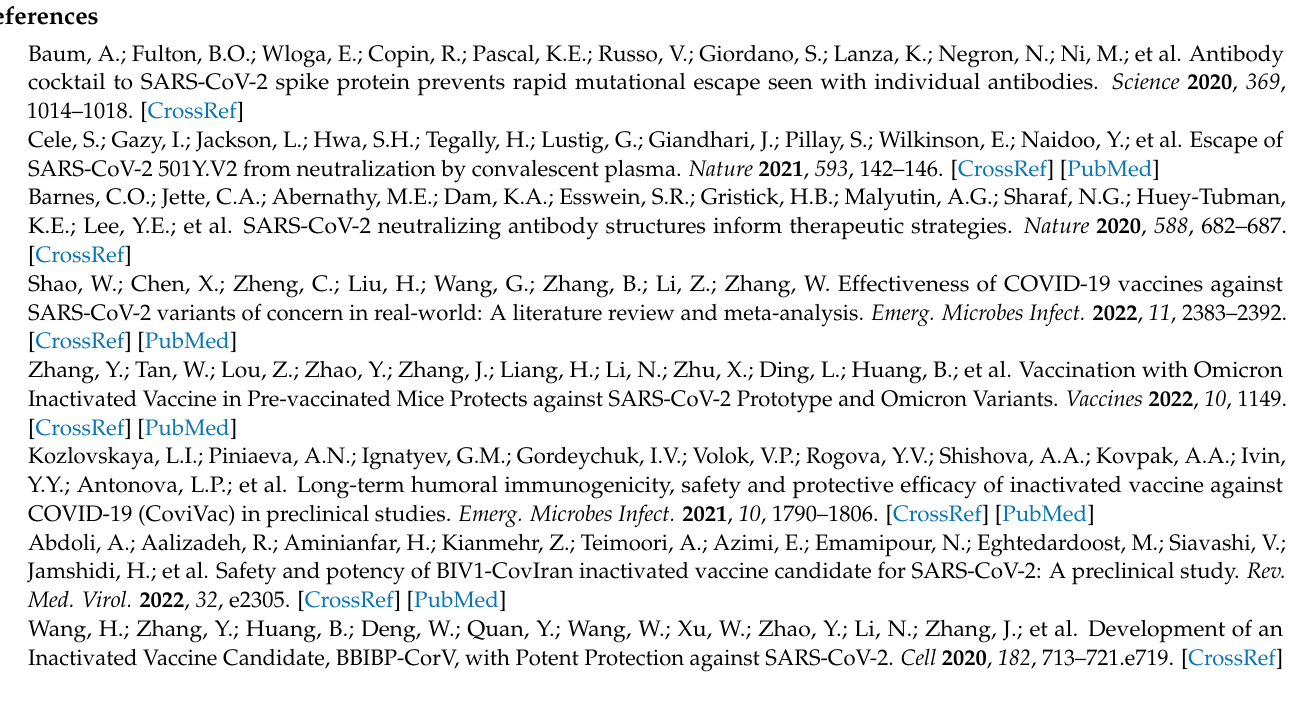
Table S2: coagulation Statistics in each group; Table S3: the blood biochemical indicators of animals in each group; Table S4: urine test data in each